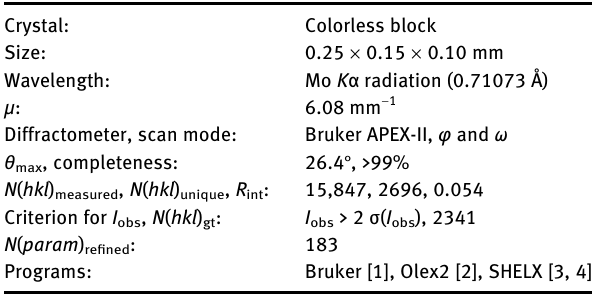
Table  : Data collection and